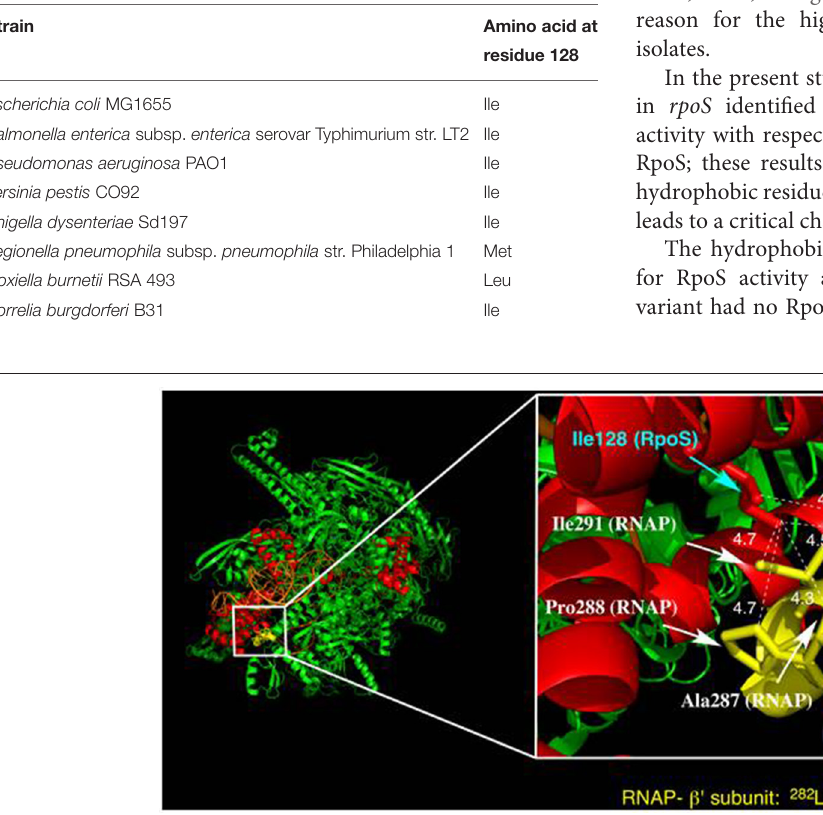
Frontiers in Microbiology |